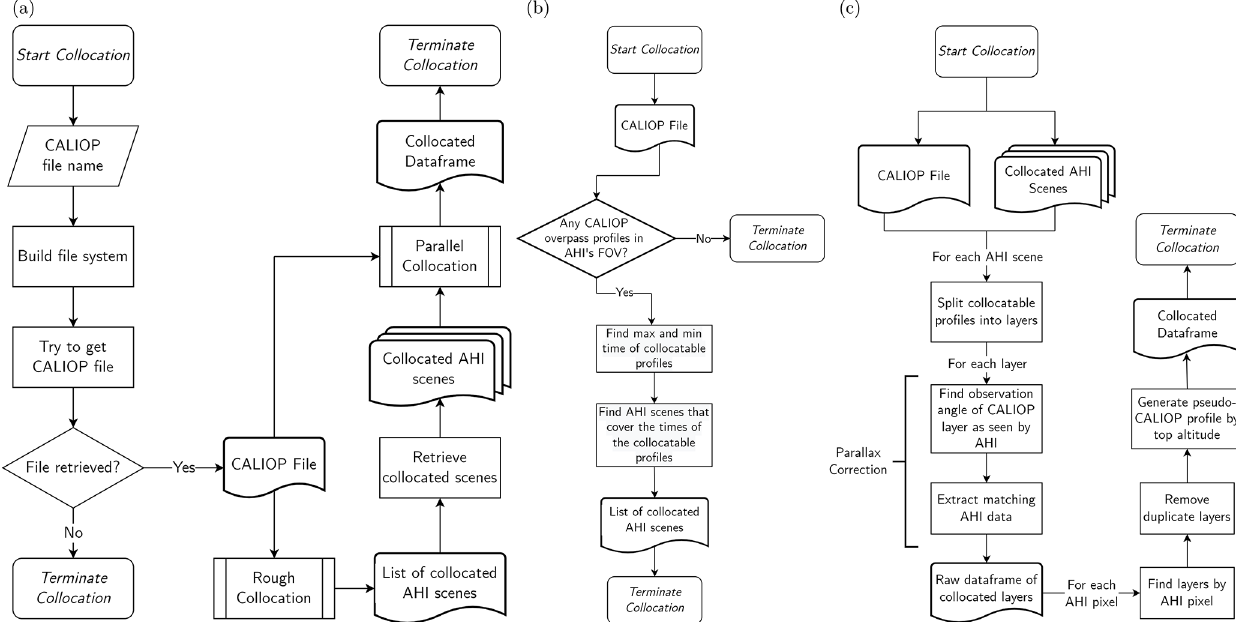
Figure 1. The full collocation process for a single CALIOP file. The full process from CALIOP file to collocated data frame is described in panel (a) , whilst the processes of finding collocated AHI scenes and collocating CALIOP profile layers are described in panels (b) and (c) ,